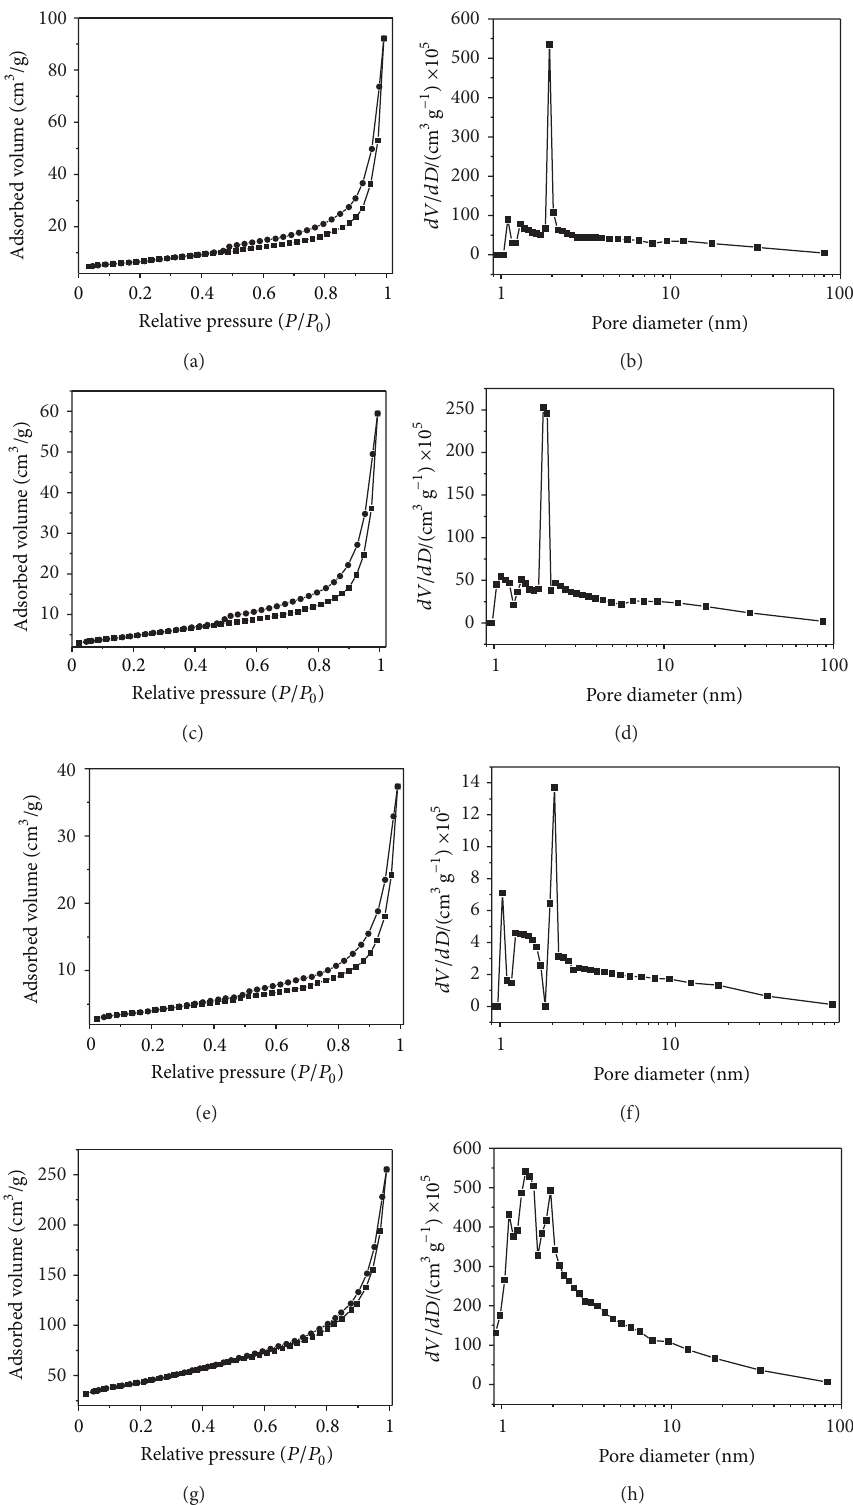
Figure 5: N 2 adsorption-desorption isotherms of CN-T (a), CN-D (c), CN-M (e), and CN-U (g) and the corresponding pore size distribution curves of CN-T (b), CN-D (d), CN-M (f), and CN-U